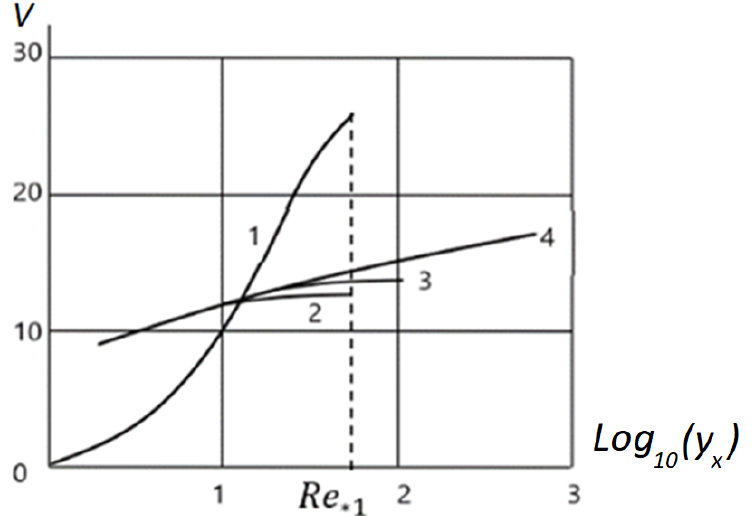
Figure 5. Velocity profiles: 1—laminar regime when Re ∗ = 48.7; 2—turbulent regime when Re ∗ = 48.7; 3, 4—turbulent ones when Re ∗ equals 100 and 413, respectively.